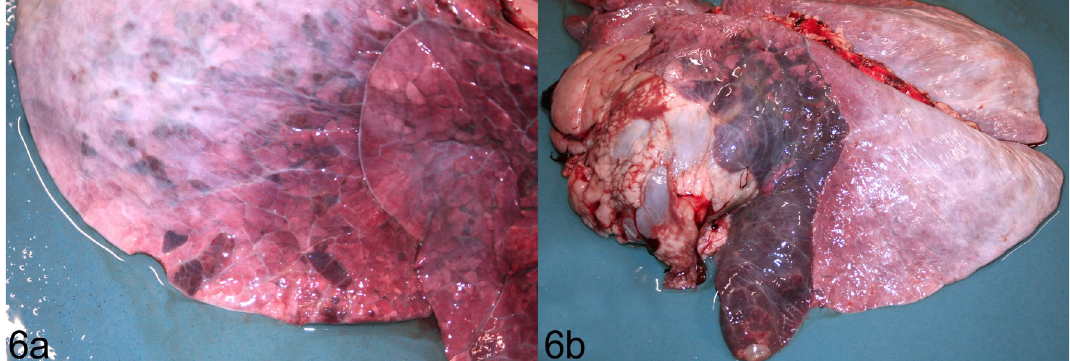
Fig 6. Gross lesions in calves challenged by aerosol with Mannheimia haemolytica . A) Lobular areas of red-purple color and firm texture. Lesions affect 15% of the right lung based on image analysis. Calf pair #1, water-treated (control). B) The left cranial lobe of the lung is almost entirely consolidated, red-purple, and collapsed. Lesions affect 39% of the left lung based on image analysis. Calf pair #4, water-treated.